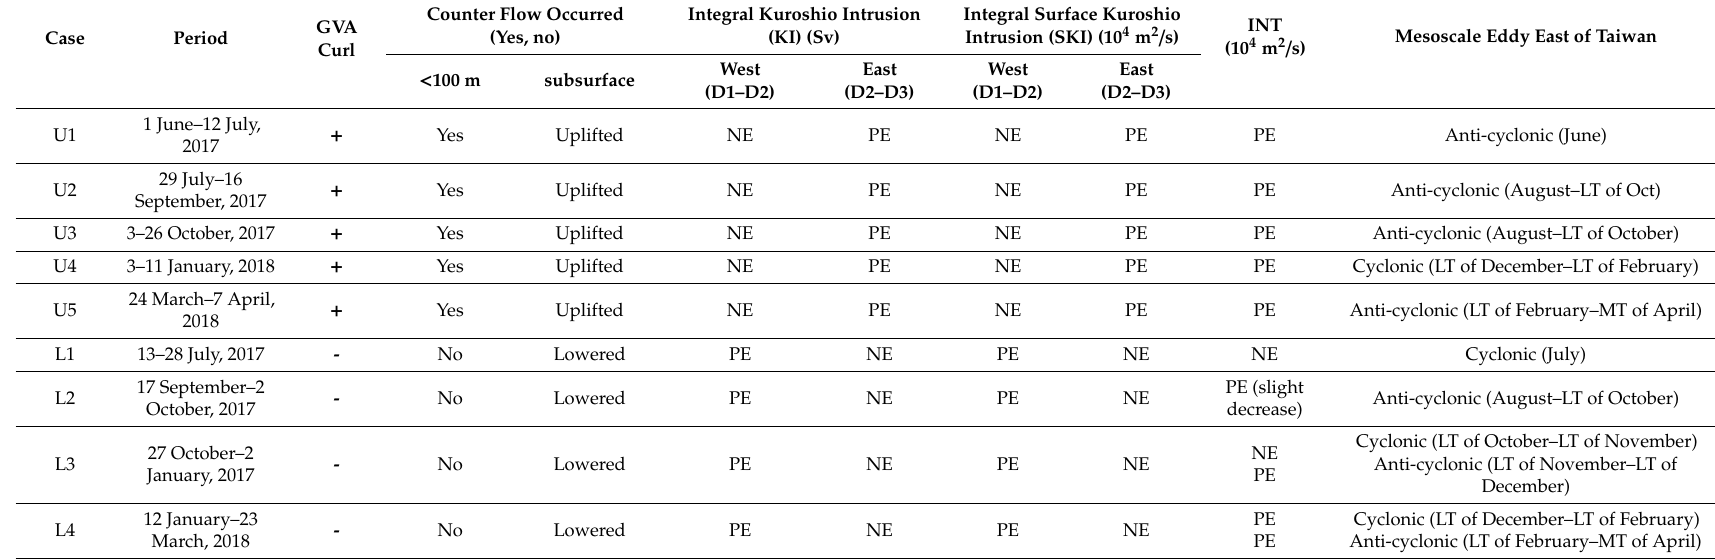
Table 1. The information on di ff erent cases of the counter-flow and Kuroshio